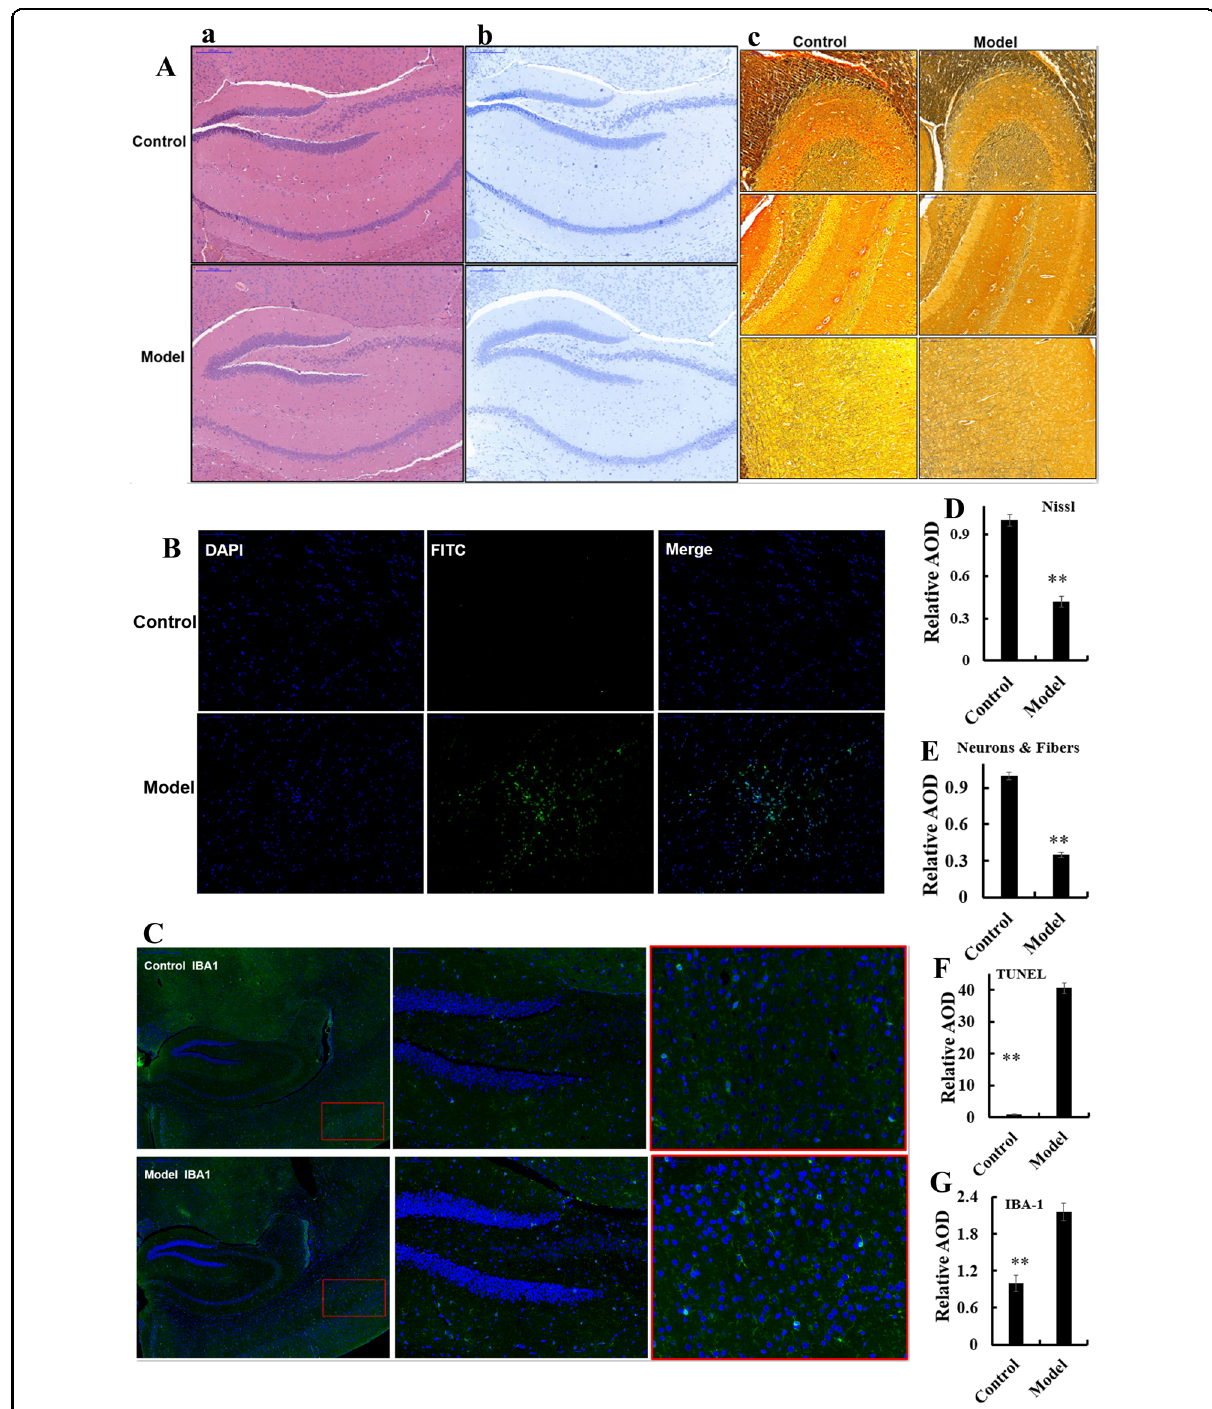
Fig. 2 Dysbacteriosis affects brain histopathology in mice fed a diet high in sugar and fat for 4 months. A Samples were stained using hematoxylin and eosin (H&E), see also Fig. S3A-a. B , D Samples underwent Nissl staining, see also Fig. S31A-b. C , E Samples were stained using silver, see also Fig. S3A-c. D , F Samples underwent TUNEL staining, see also Fig. S3A-d. C , G Samples were stained using immuno fl uorescent microglial of IBA-1, see also Fig. S3B-b. Data are the mean ± SD of 5 independent experiments. * p < 0.05 and ** p < 0.01 vs. the model group by one-way ANOVA, followed by the Holm – Sidak